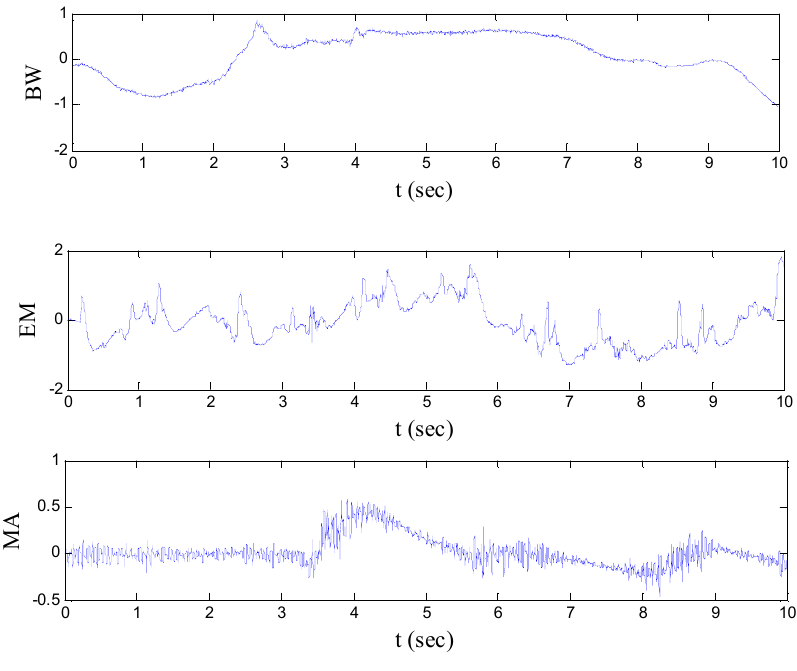
Figure 5. Realistic noise signals.